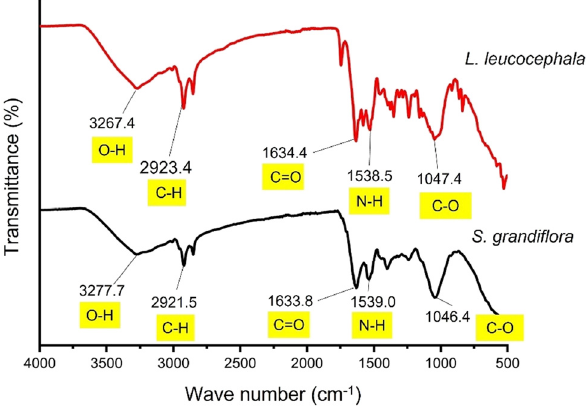
Figure 1: FT - IR peaks of active groups in the L. leucocephala and S. grandi fl ora